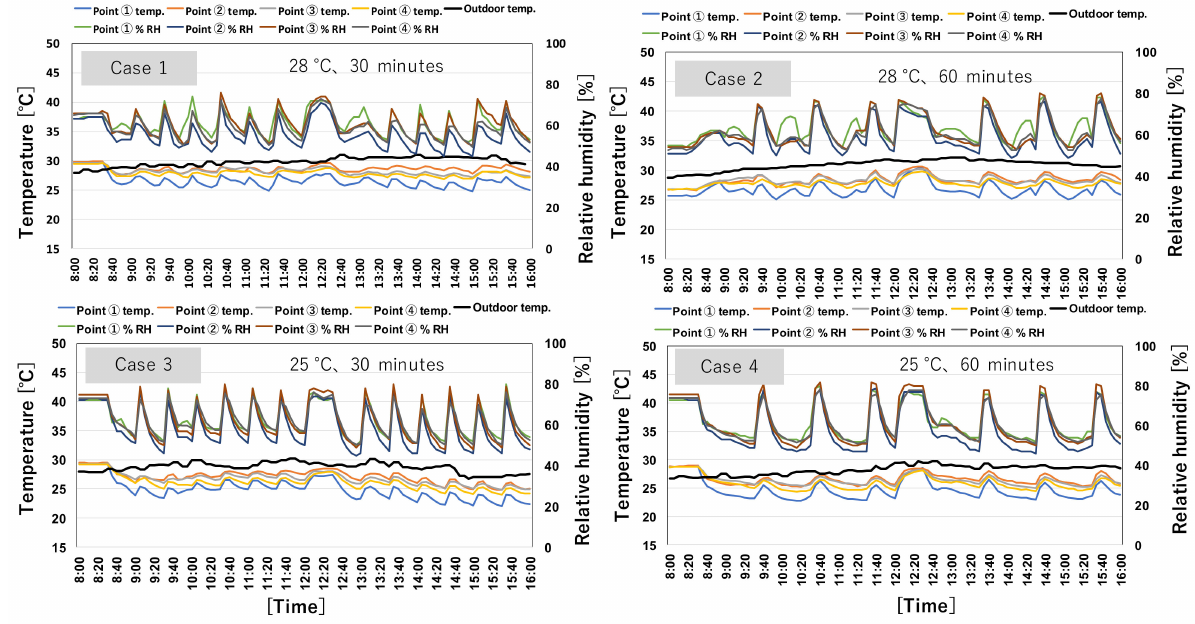
Figure 4. Changes of indoor temperature and relative humidity in